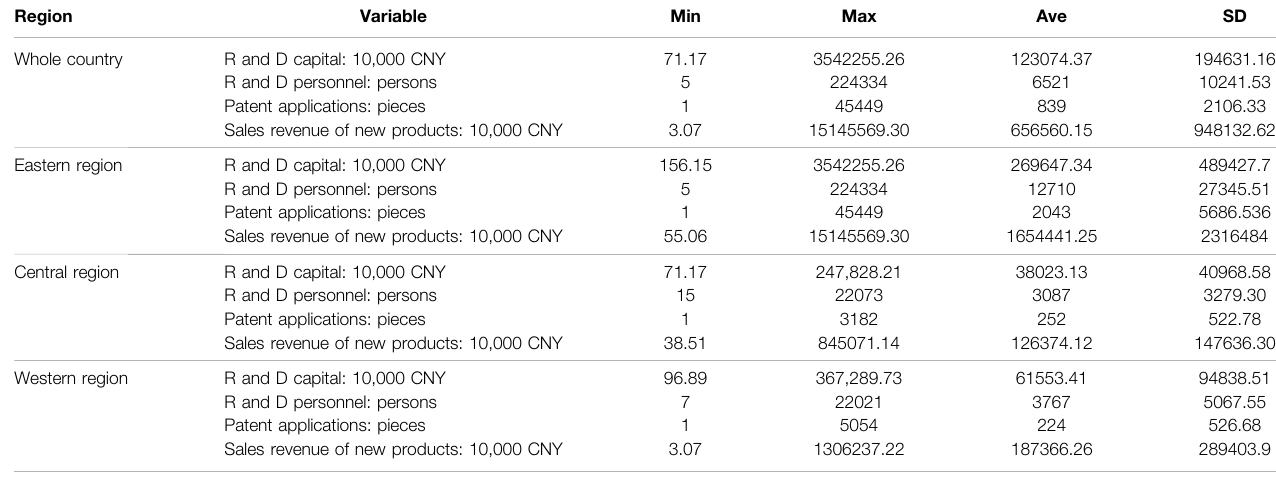
TABLE 1 | Descriptive statistical characteristics of the innovation input and output for the high-tech industry in China ’ s provinces. Region